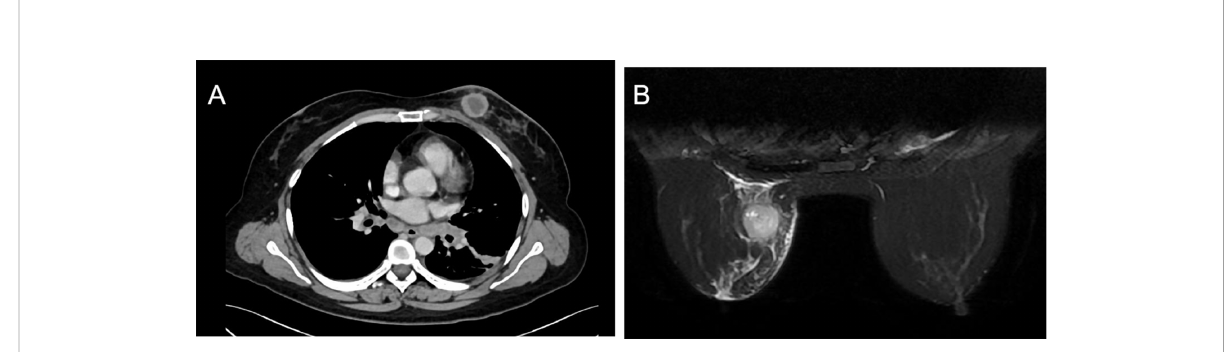
FIGURE 1 Chest CT. Chest CT before treatment (A) . Chest MRI before treatment (B)